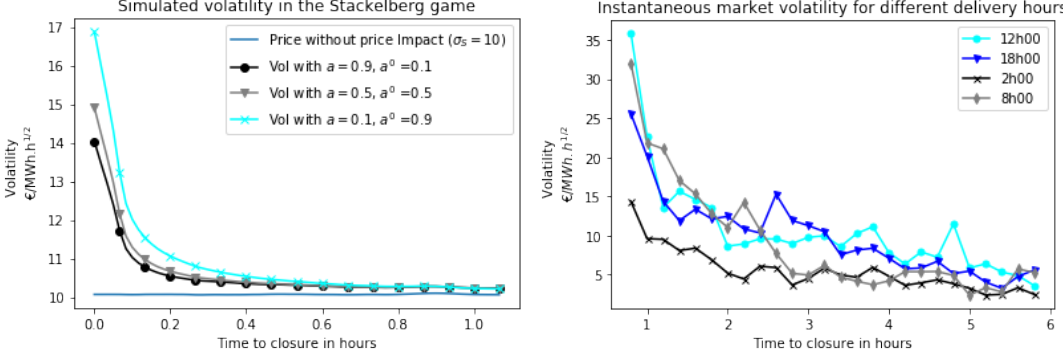
Figure 2. ( Left ) volatility of simulated prices for different market shares of the major agent. ( Right ) volatility for different delivery hours, estimated empirically from EPEX spot intraday market data of January 2017 for the Germany delivery zone.